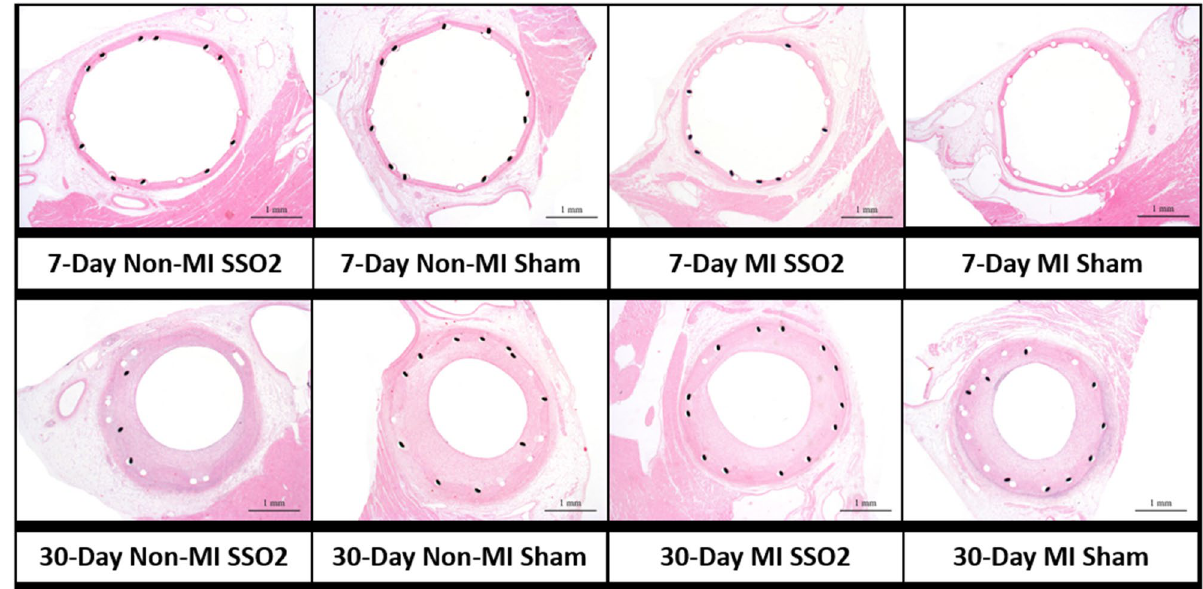
Figure 6. Representative in-stent coronary arterial cross-sections from all 8 study subgroups. Typical histological responses to stent placement in normal porcine arteries at 7 days (upper panels) and 30 days (lower) panels. No excess early thrombus formation at 7 days or excess neointima formation at 30 days are seen as a result of SSO 2 therapy in comparison to sham. Note : Figs. 1, 2 and 6 generated with Microsoft Office 365 utilizing histology and histomorphometry images generated with ImagePro Plus (MediaCybernetics). Figs. 3, 4 and 5 generated with SigmaPlot v 11.0 (Build